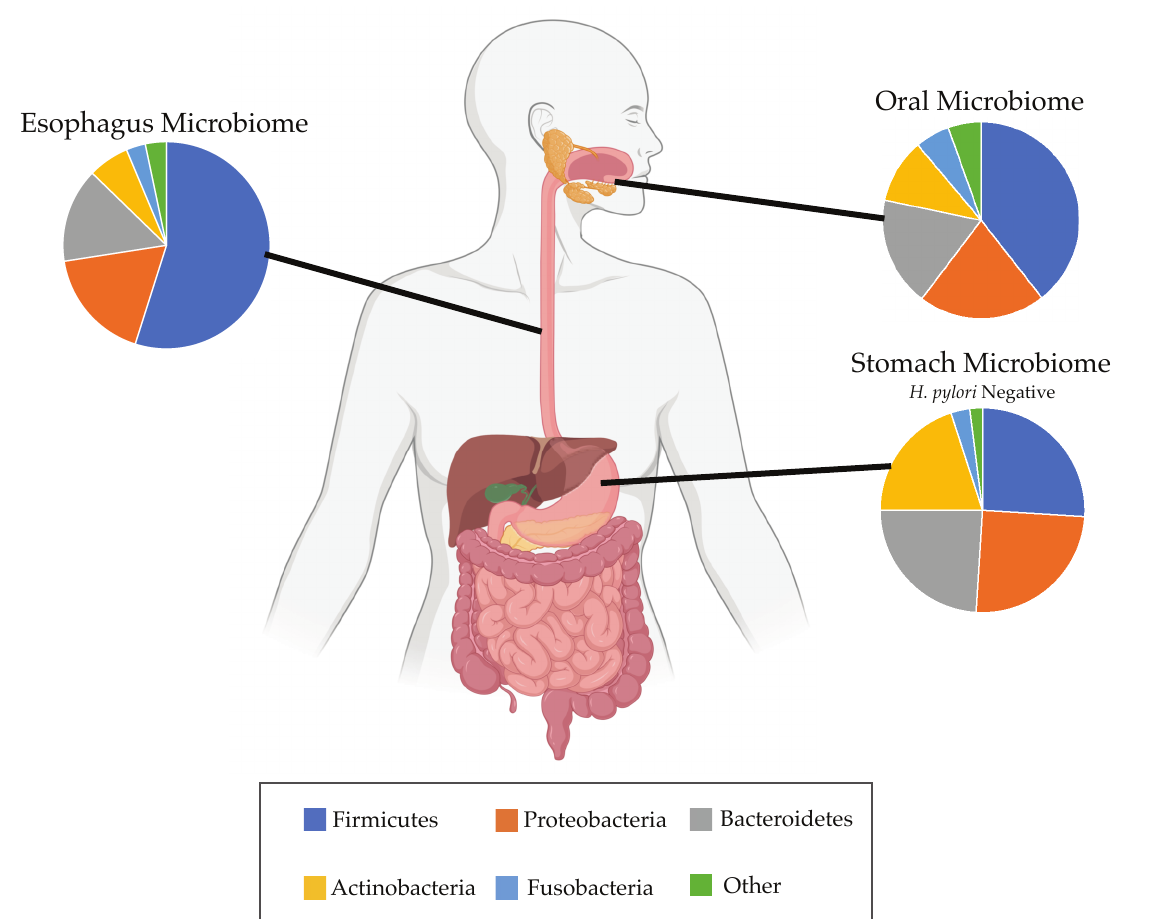
Figure 2. Microbiome of a healthy patient. Microbial abundances at the phylum level from patients without Barrett’s esophagus or cancer shown for the oral [14,18,89], esophageal [34–36,38,39,53] and H. pylori negative gastric [14] micro- biomes. Esophageal microbes can migrate from and between the stomach and oral cavity, therefore influencing the expected diversity of the esophageal microbiome in clinical